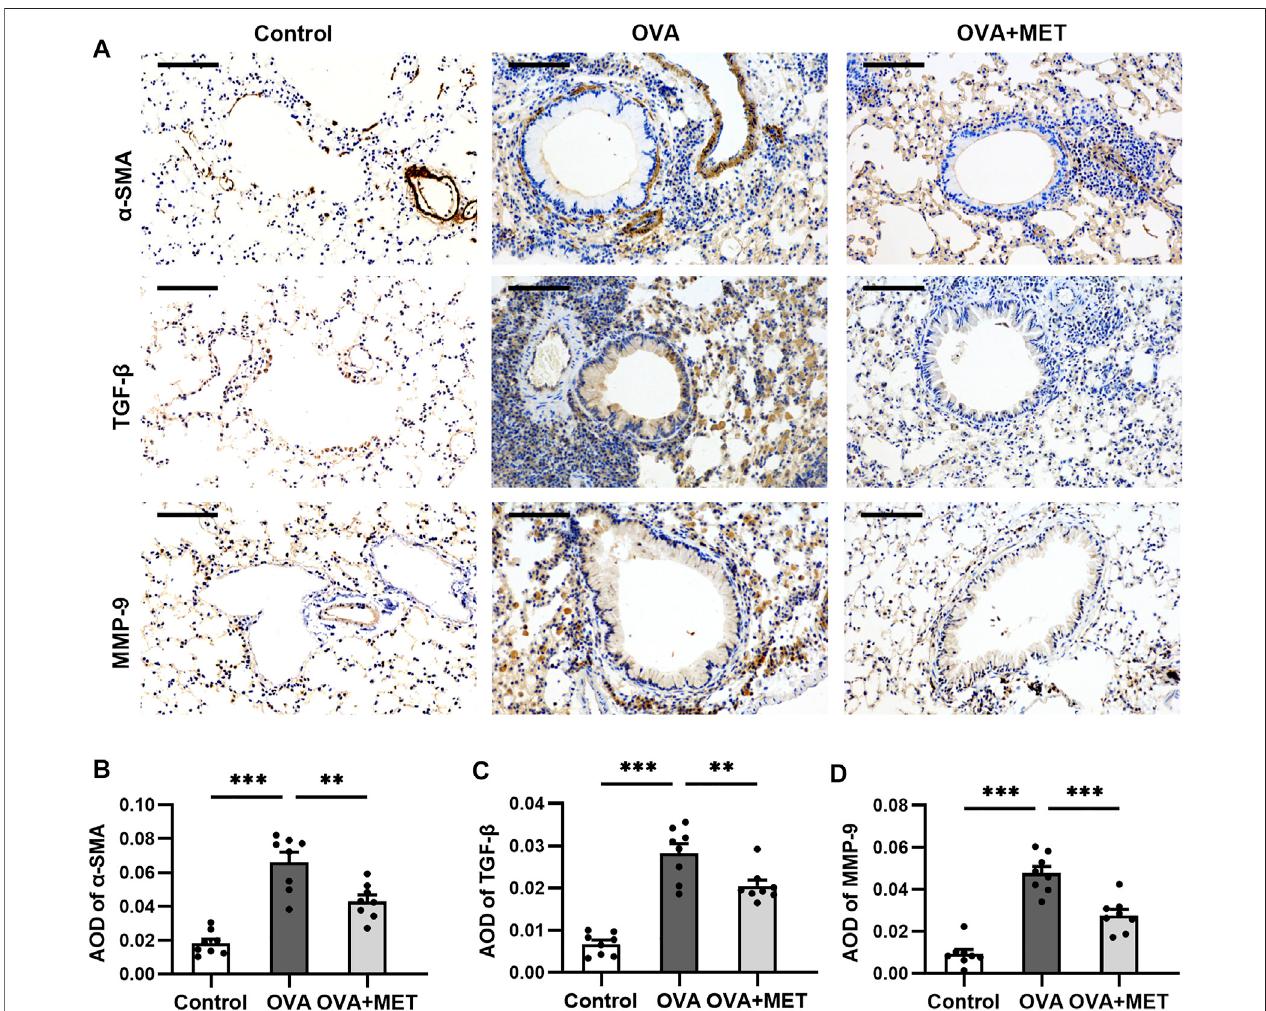
FIGURE3| Metforminhasananti- fi broticeffectinamurinemodelofchronicasthma. (A) .Representativeimagesof a -SMA,TGF- β andMMP-9immunoreactivityin lung tissues. (B – D) . Blinded quantitative analysis of immunohistochemical staining density [(integral optical density)/area; IOD/area] for a -SMA, TGF- β and MMP-9 by Image-ProPlus.Datawerepresented asmean ± SEM( n (cid:1) 8animals,20bronchioles/3 sectionsofananimal,each bronchiole with100 – 200 μ mofinternaldiameter).All images are at × 200 magni fi cation. Scale bar (cid:1) 100 μ m * p < 0.05, ** p < 0.01, *** p <